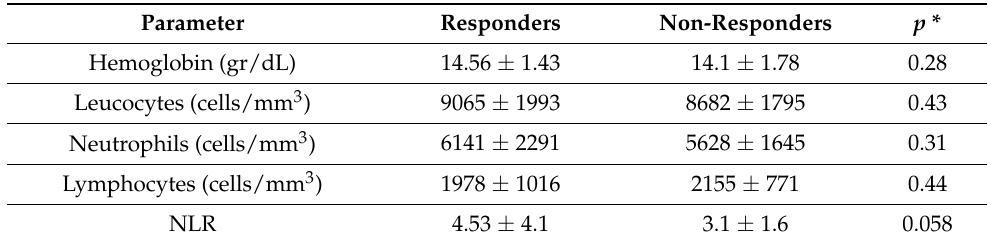
Table 2. Mean values ( ± standard deviation) of the hematological parameters in responders and non-responders to induction chemotherapy (ICT).